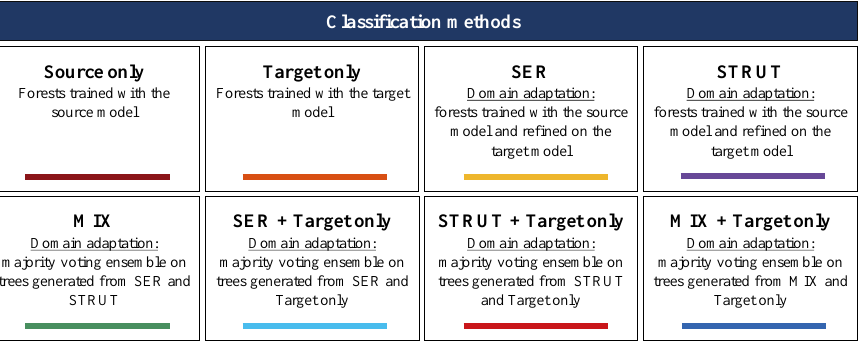
Figure 3. Scheme of the classification methods employed in each experiment.